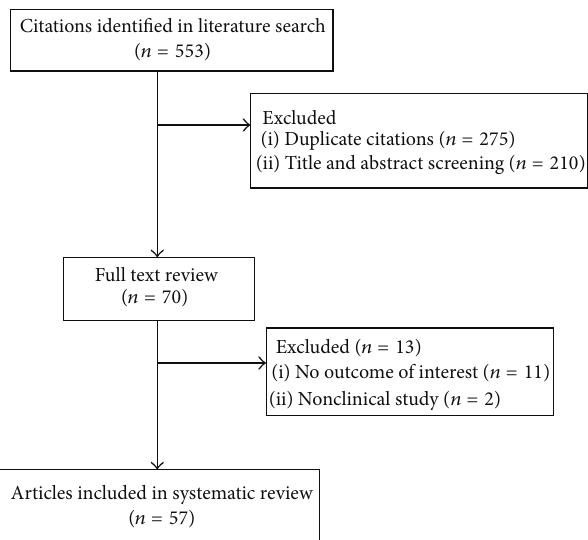
Figure 1: Flow diagram of literature search